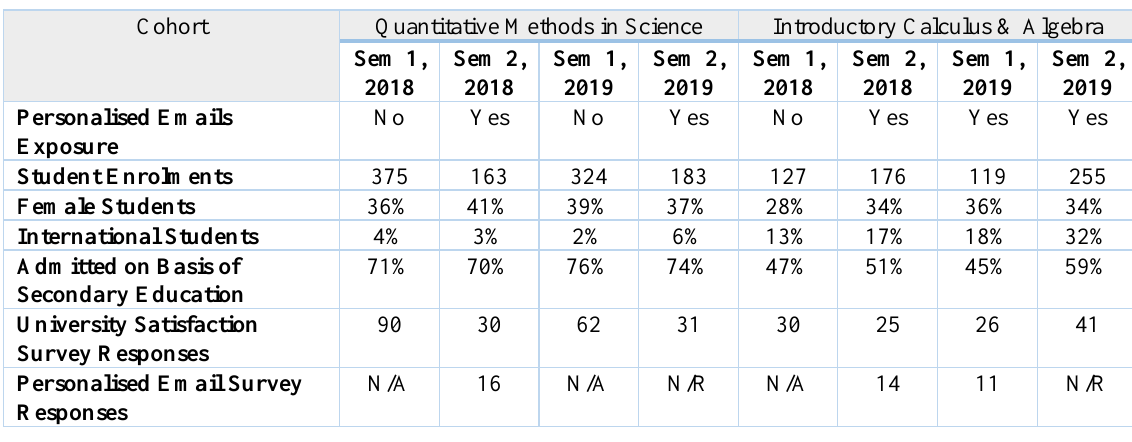
Student Enrolments and Survey Response Rates by Cohort; N/A is not Applicable, and N/R is not